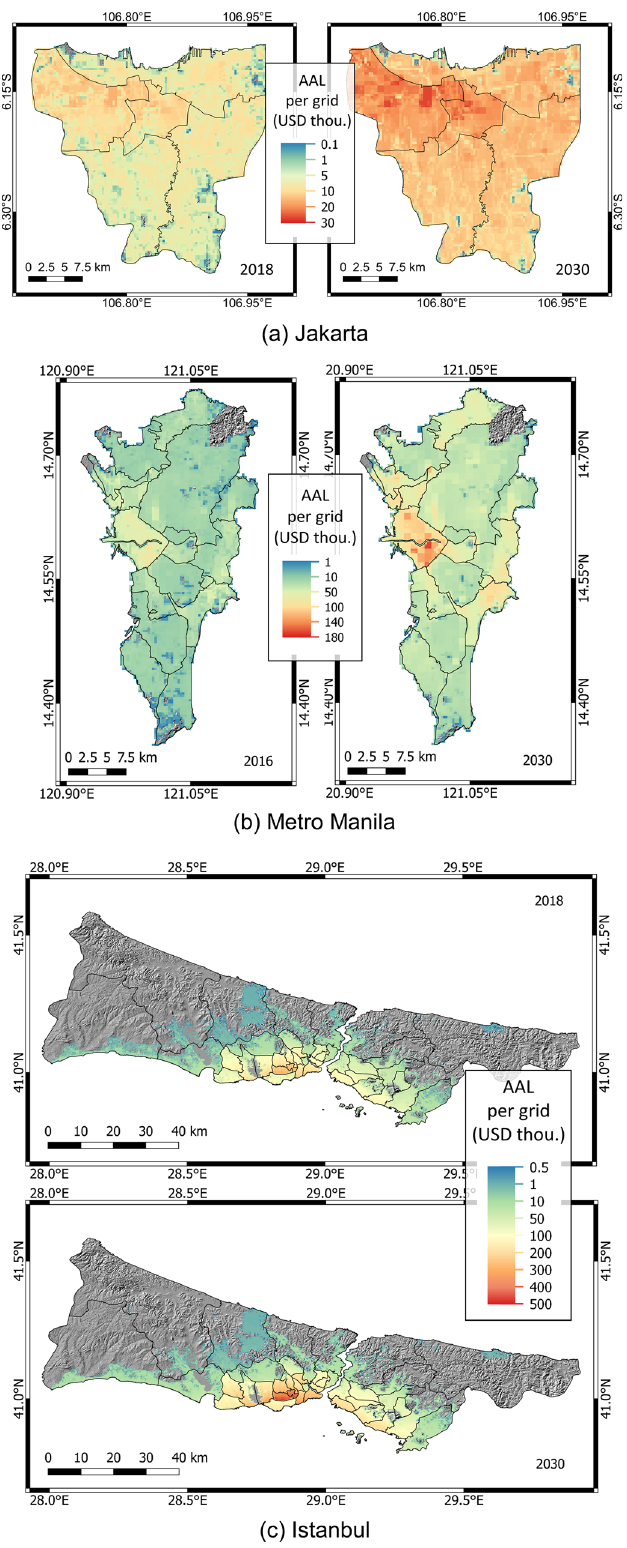
Fig. 4 Macro-level loss estimates for grids (270m spatial